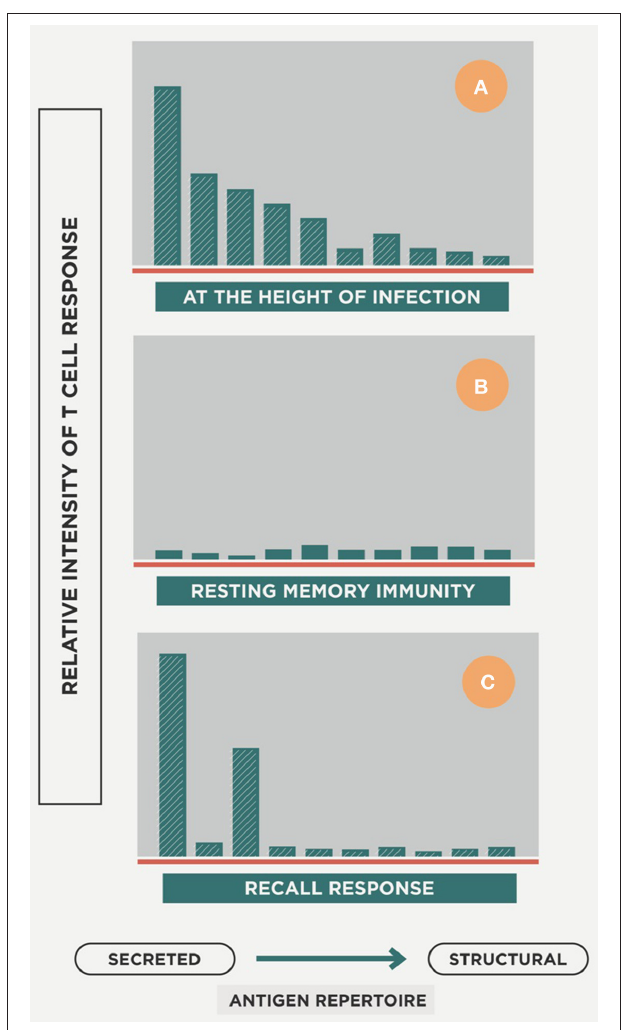
FIGURE 4 | Host response repertoire against Mtb infection. The picture illustrates how, at the onset of infection, a wide-ranging cellular response is induced against a large epitope repertoire that mainly includes secreted antigens but also structural ones (A) . Once the acute phase is controlled and there is a majority of non-replicating Mtb (NR-Mtb; Muñoz-Elías et al., 2005), the immune response decreases while maintaining the memory status (B) . Once reinfection occurs, the immune response is triggered but essentially only against secreted antigens (C) . Modified from Andersen